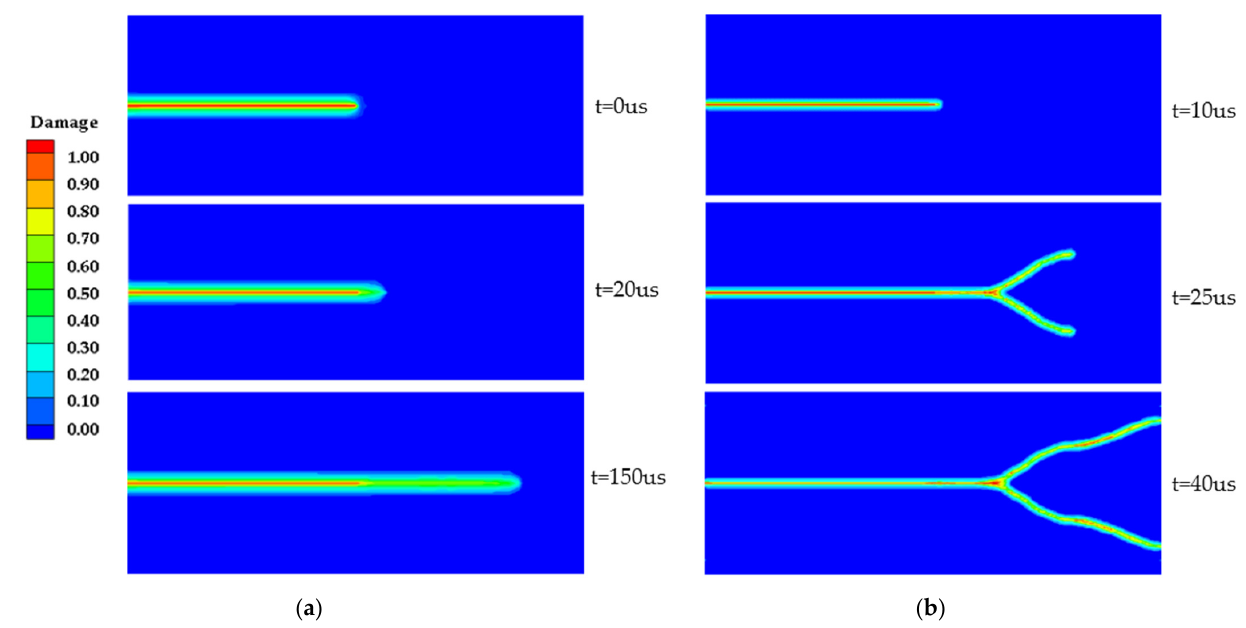
Figure 5. Crack propagation path diagram. ( a ) Crack propagation at 1.2 MPa; ( b ) crack propagation at 12 MPa.